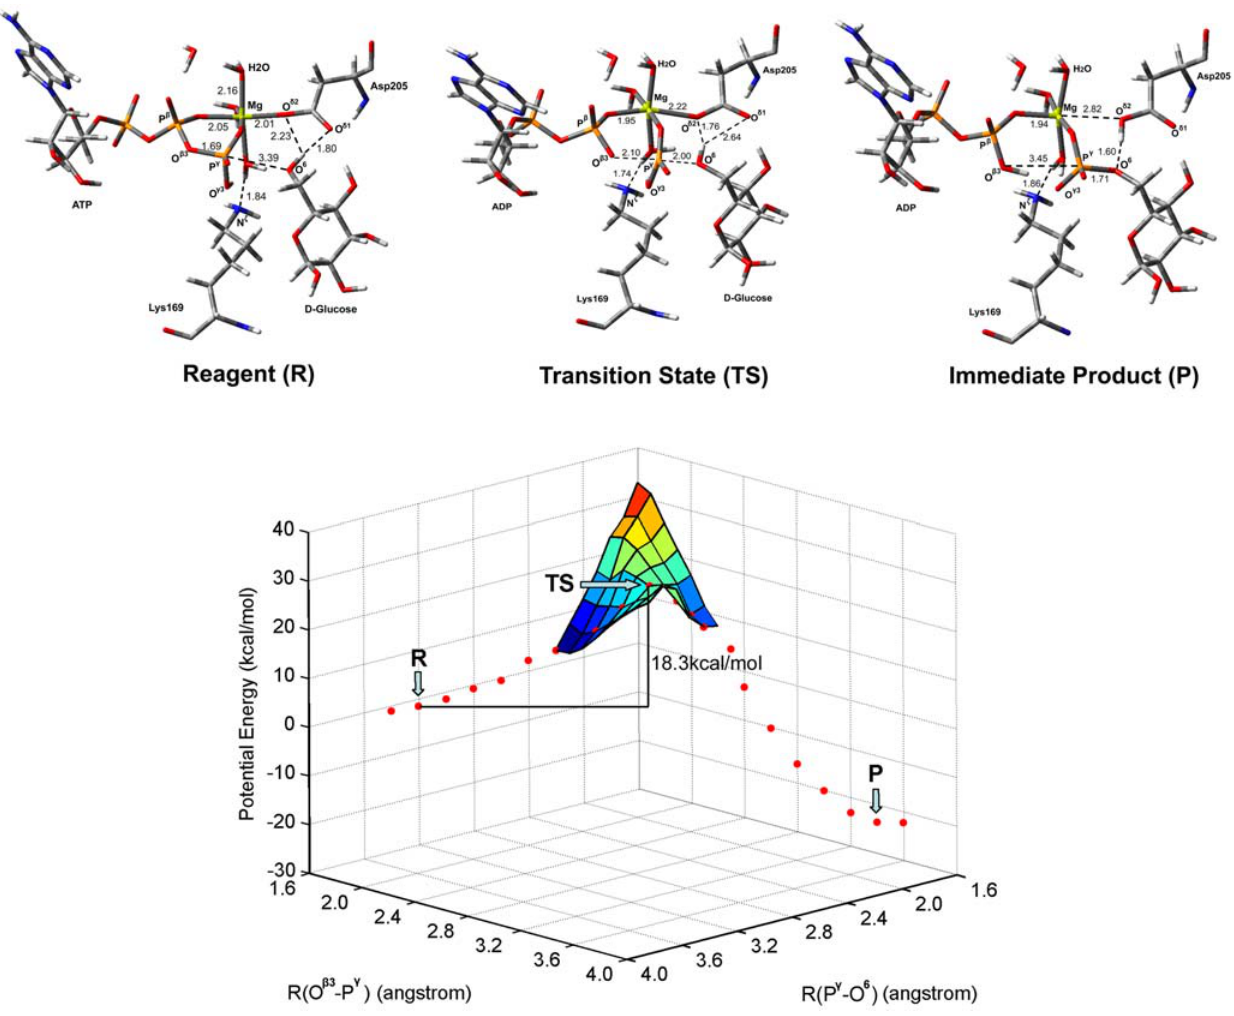
Figure 3. The potential energy surface of the reaction pathway corresponding to Scheme 1. The structures displayed at the top of the potential surface are the QM/MM optimized structures of the reagent (R), transition state (TS), and immediate product (P). For clarity, only the structures around the reaction center have been shown.